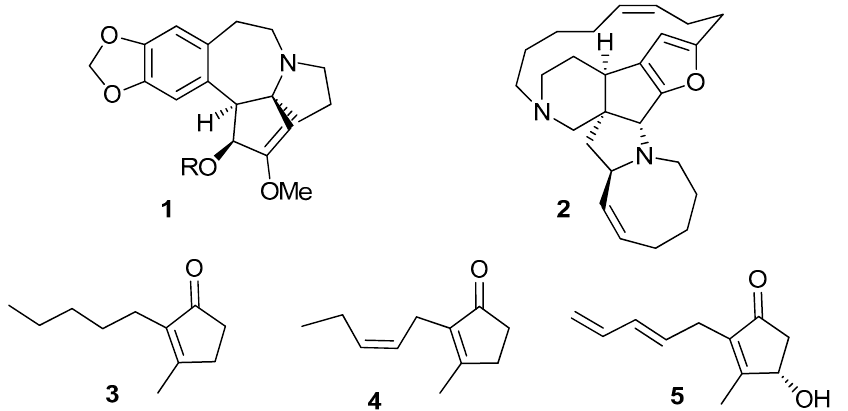
Figure 1. The cyclopentenone moiety into biologically active molecules: (2)-cephalotaxine ester derivatives 1 , (+)-nakadomarin 2 , dihydrojasmones 3 , cis-jasmones 4 and rethrolones 5.